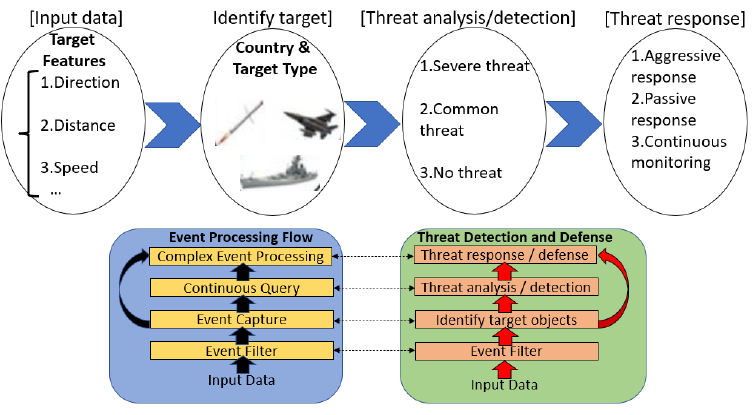
Figure 1. Rule-based event processing framework.